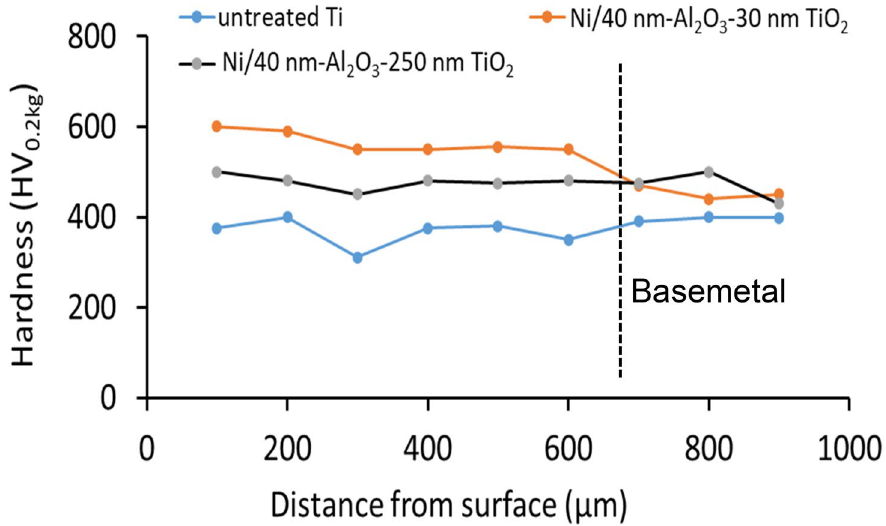
Figure 8. Hardness profile as function depth from the treated